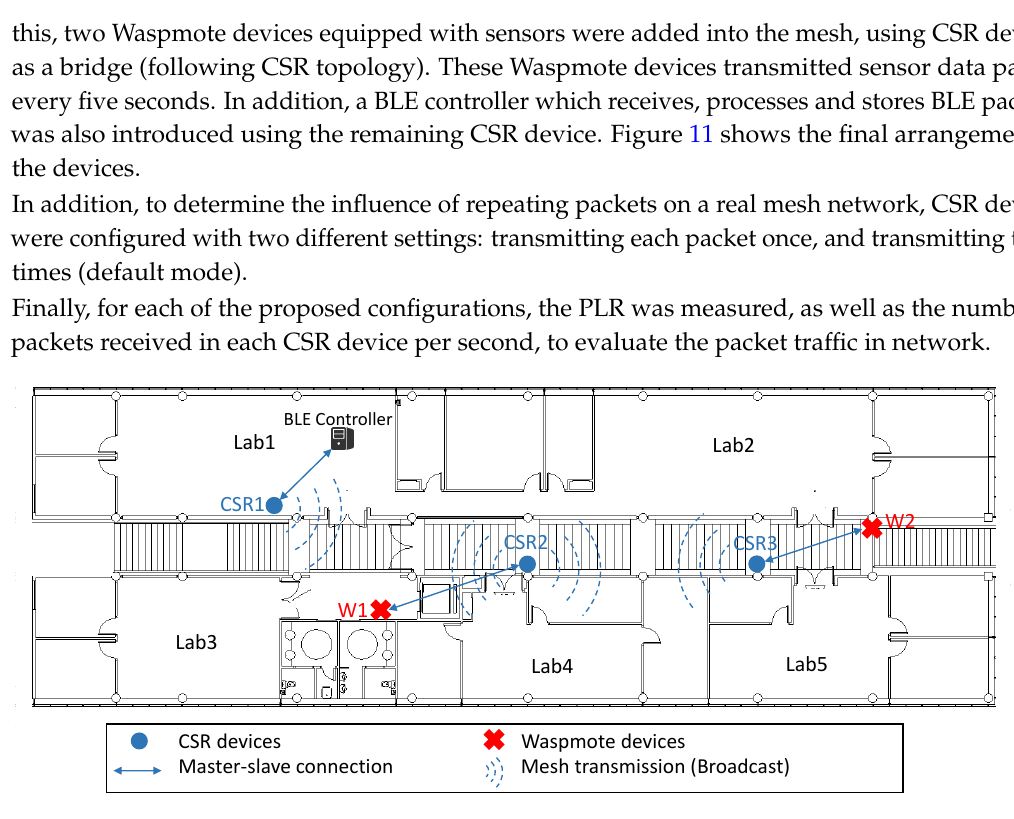
Table 3. Packets sent by sensor nodes and received by BLE server, for each CSR devices configuration.